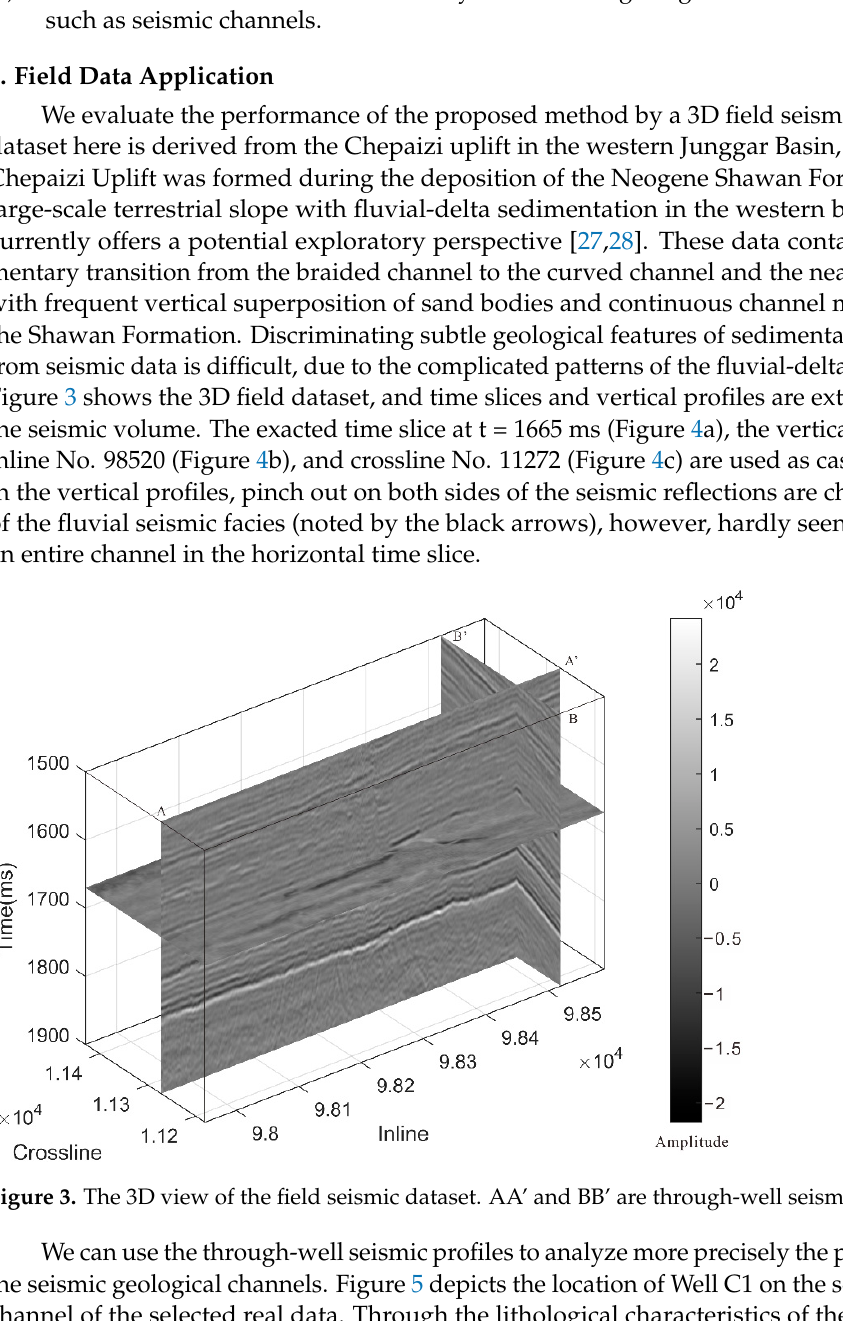
Figure 4. The location of wellbore and the through-well seismic profiles . ( a ) The time slice at t = 1650 ms; ( b ) the vertical seismic profile extracted at Crossline No. 98520; ( c ) the vertical seismic profile extracted at Crossline No. 11272. The dotted lines indicate the location of the through-well seismic profiles.